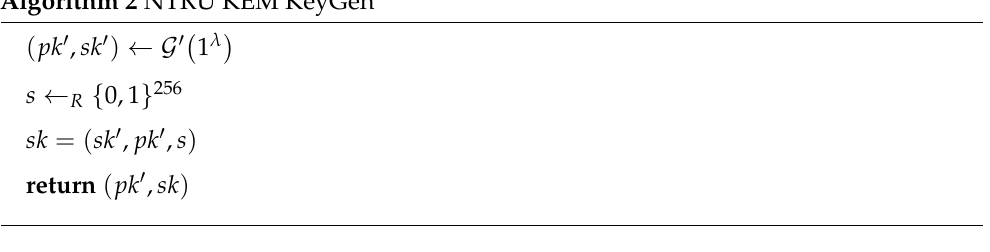
Algorithm 2 NTRU KEM KeyGen